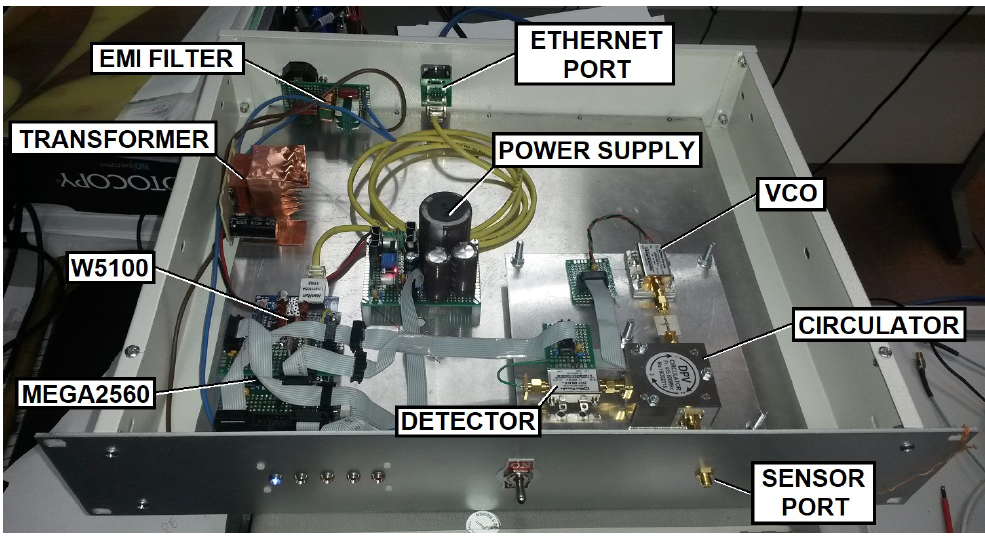
Figure 13. Manufactured SRR sensor interrogator.